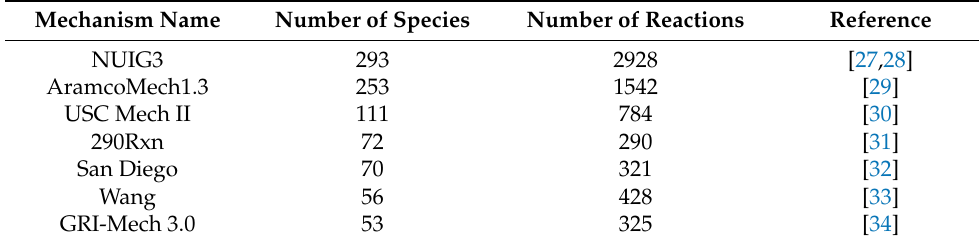
Table 2. The used chemical kinetic